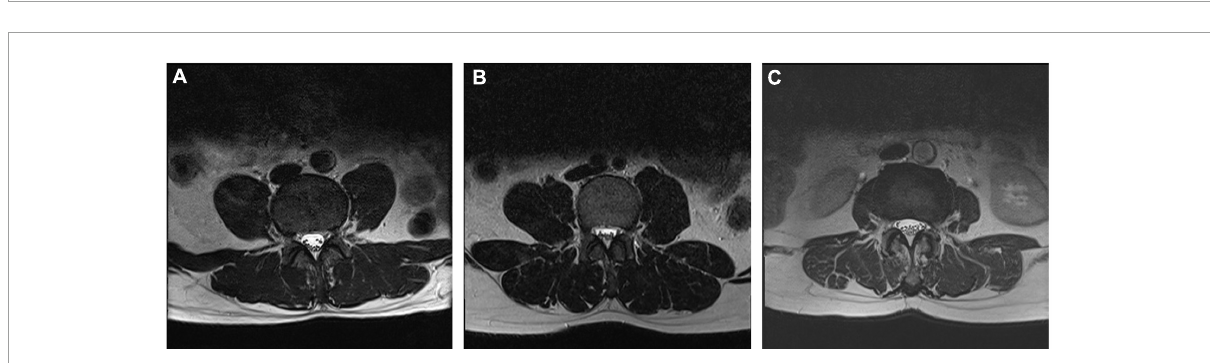
FIGURE2 Representative MRI images used for Weishaupt grading system of lumbar facet joint degeneration. Axial T2-weighted views showing grade 1 (A) , grade 2 (B) , and grade 3 (C) osteoarthritis of the lumbar facet